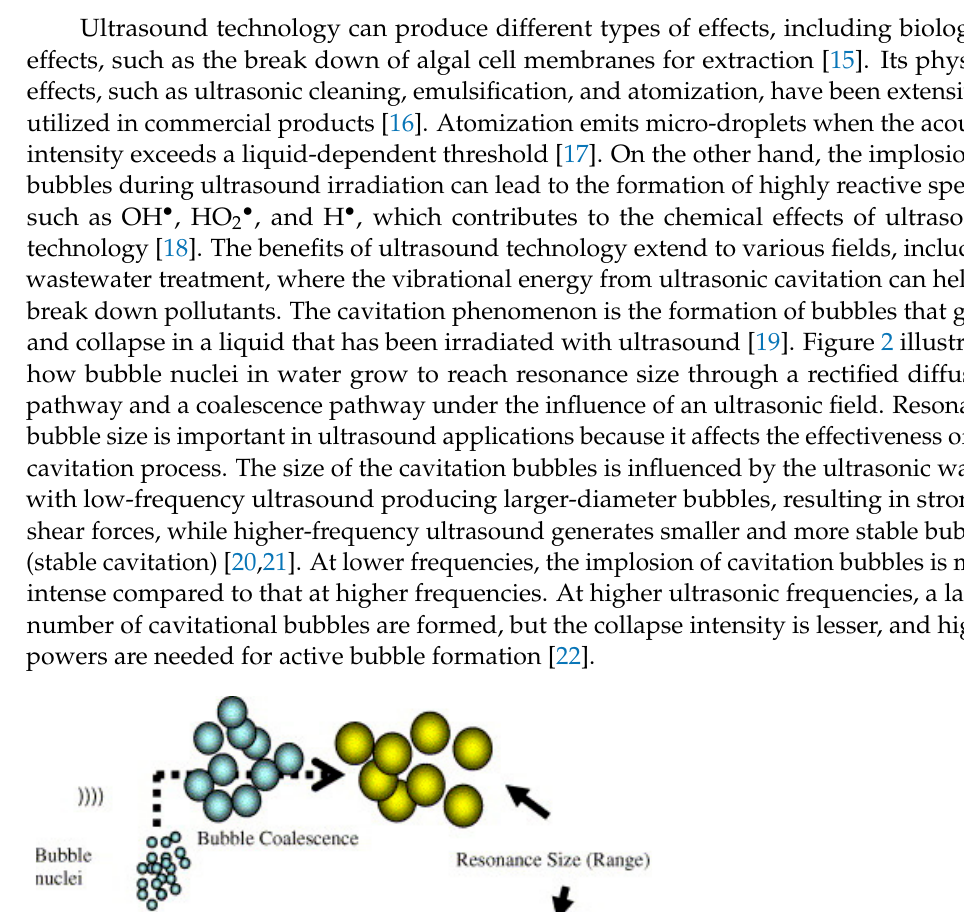
Figure 1. Energy transformation in ultrasonic applications.